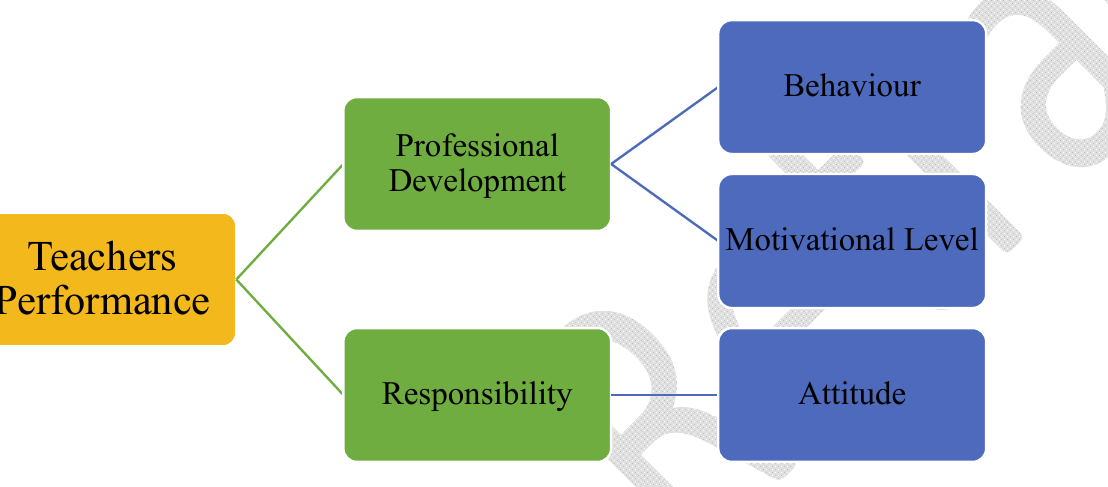
Fig. 2. Various Factors Effecting Teacher’s